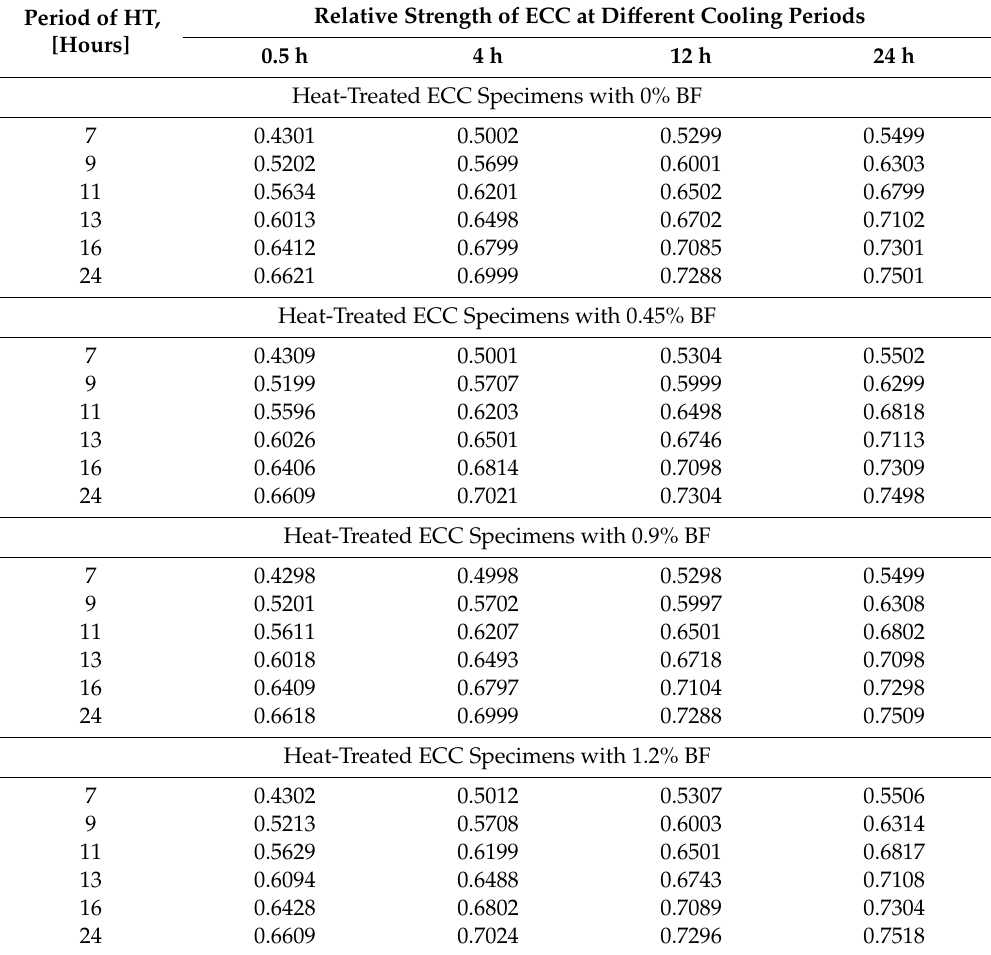
Table 7. Calculated data of the relative strength of BF-reinforced ECC specimens at different periods of HT. Period of HT,